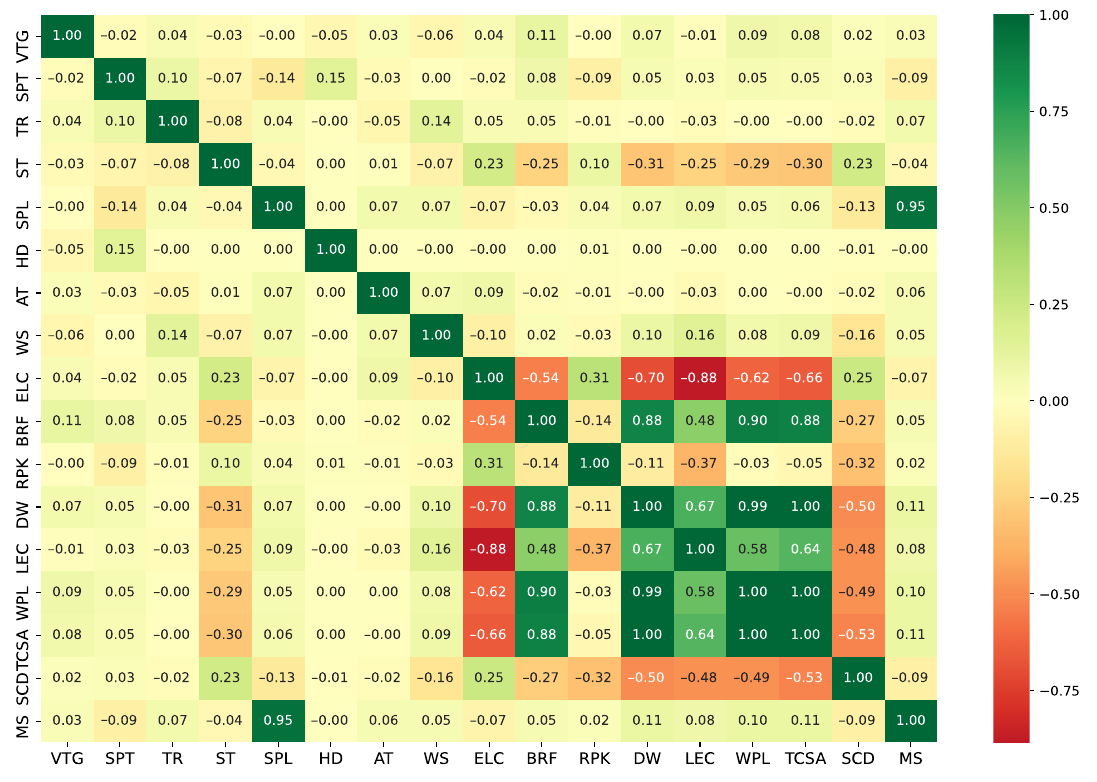
Figure 6. The correlation matrix diagrams of